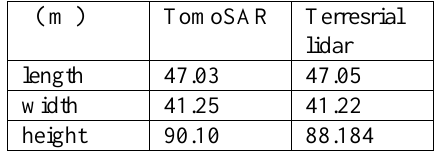
Table 1. The Results Of